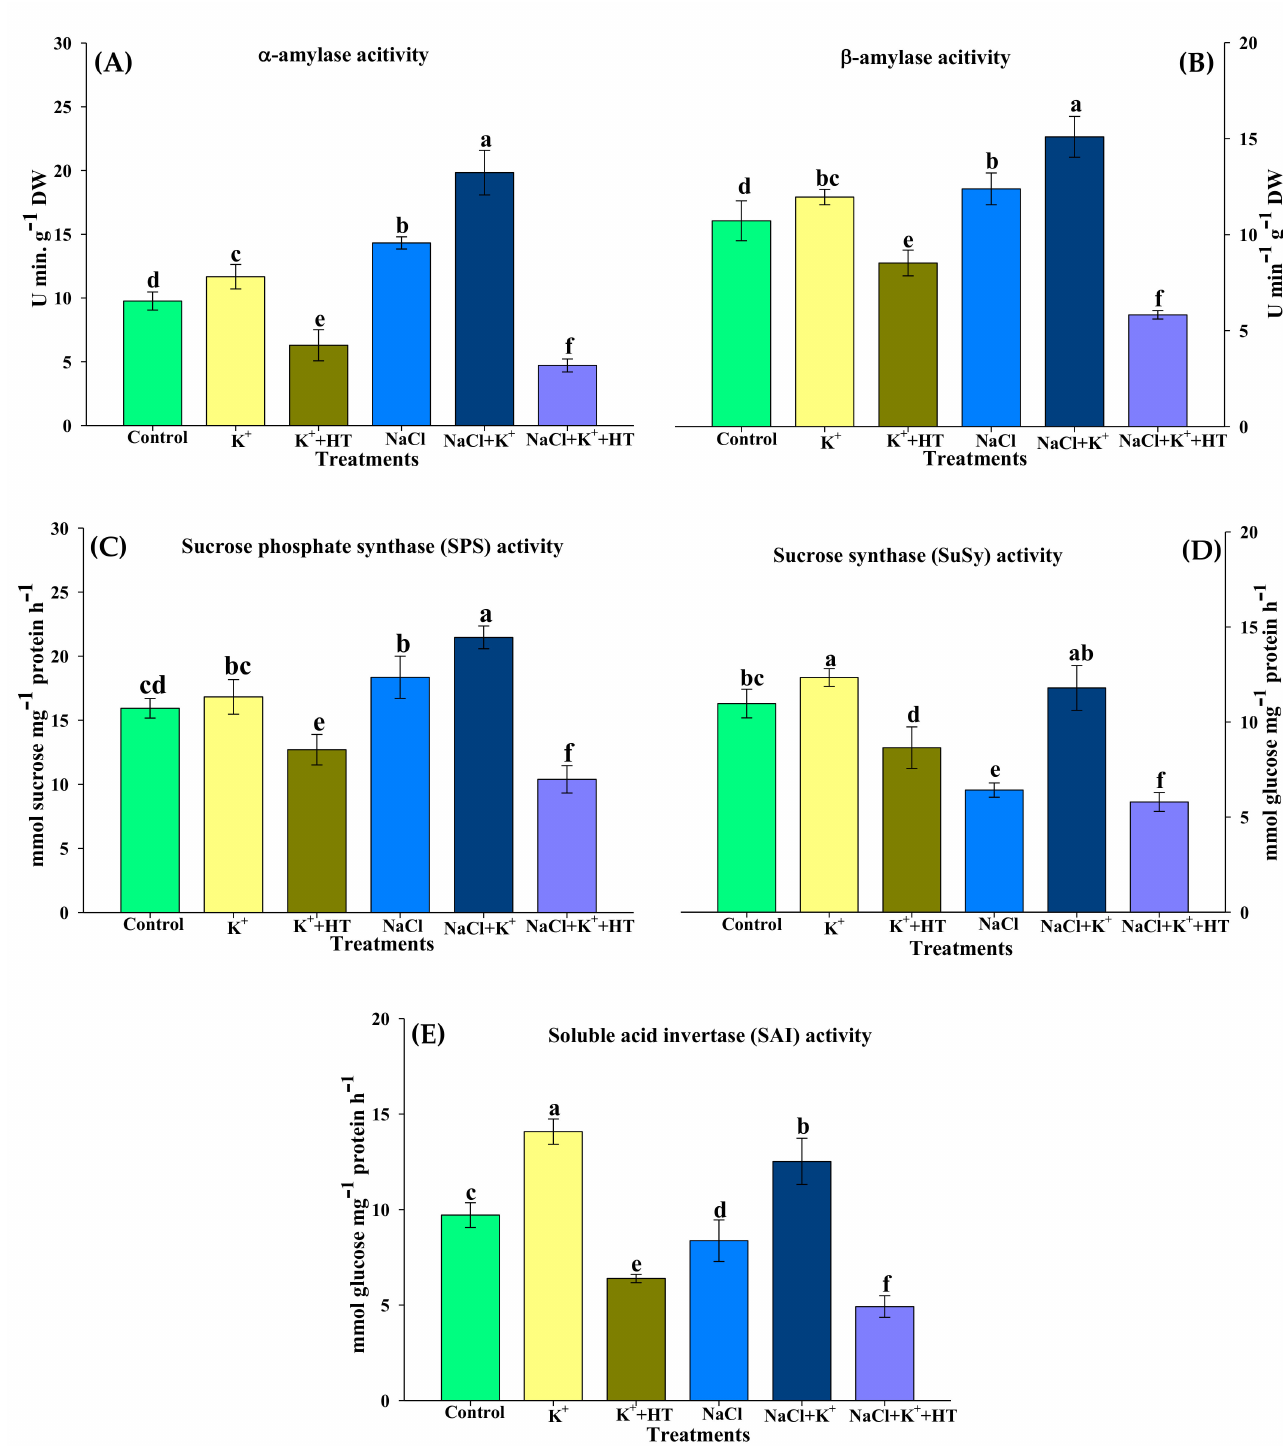
Figure 9. Effect of K + and NaCl on the activity of enzymes inolved in carbohydrate metabolism. ( A ) α -amylase activity, ( B ) β -amylase activity, ( C ) sucrose phosphate synthase (SPS) activity, ( D ) sucrose synthase (SuSy) activity, and ( E ) soluble acid invertase (SAI) activity in tomato roots. Double deionized water (control), 5 mM K 2 CO 3 (K + ), 100 mM NaCl (NaCl), 1 mM hypotaurine (HT: H 2 S scavenger). Values are means of five independent replicates, with bars indicating SE. Bars with different letters indicate that differences were statistically significant at p < 0.05